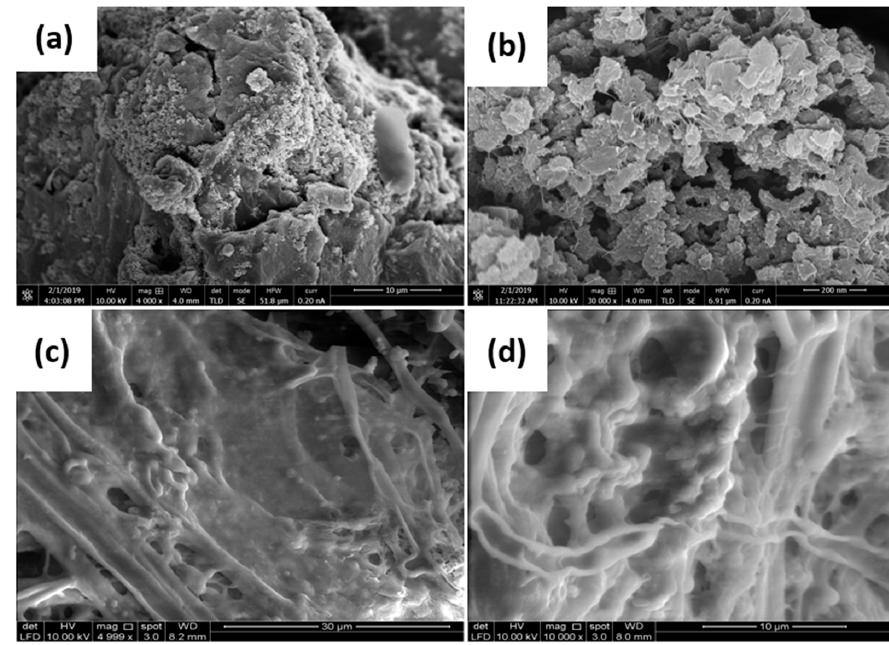
Figure 10. SEM images of fabricated anode biofilms before and after BMFCs operation ( a ) untreated GO anode (b) untreated GO-PANI anode ( c ) treated GO anode ( d ) treated GO-PANI anode.